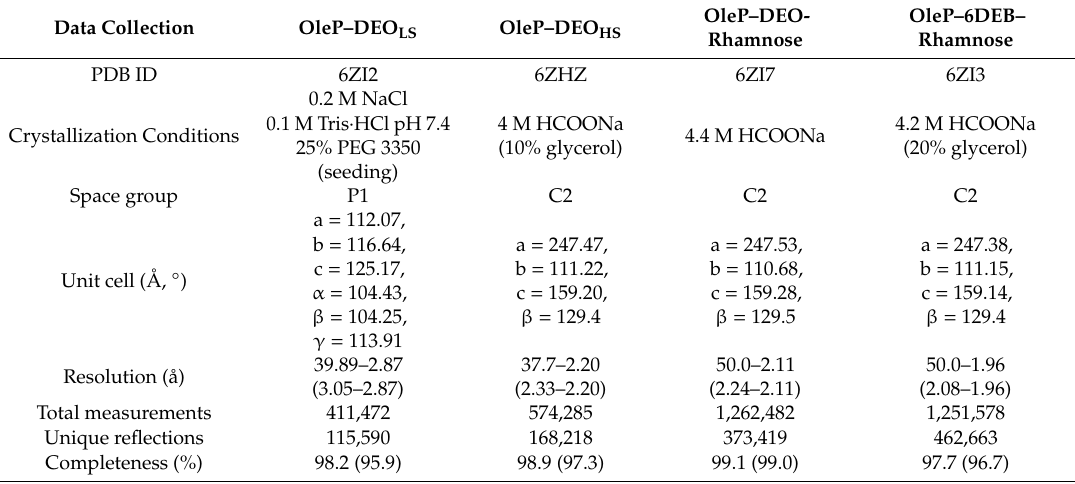
Table 1. Data collection, refinements, statistics, and validation. Highest-resolution shell is shown in